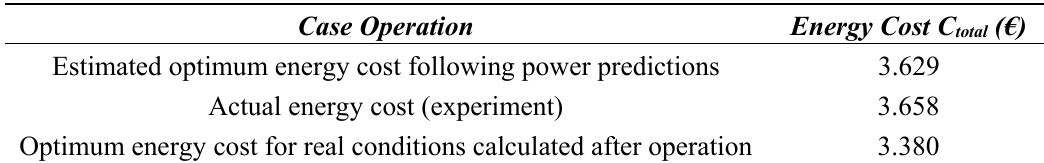
Table 2. Energy Cost